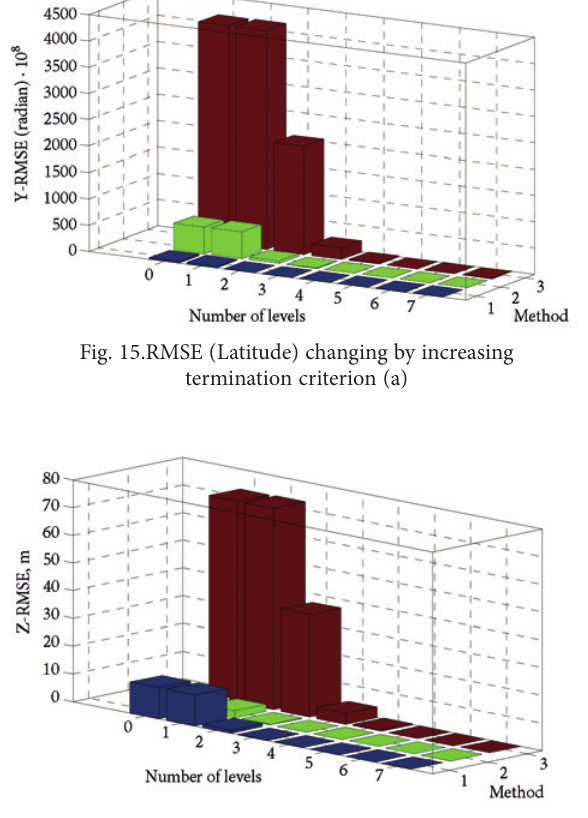
Fig. 16. RMSE (Height) changing by increasing t ermination criterion (a)